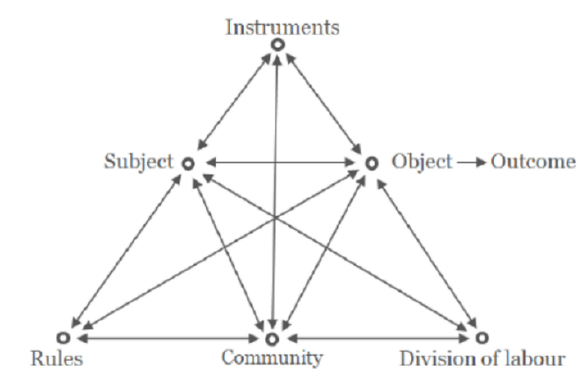
Figure 1: Activity System (Engeström,